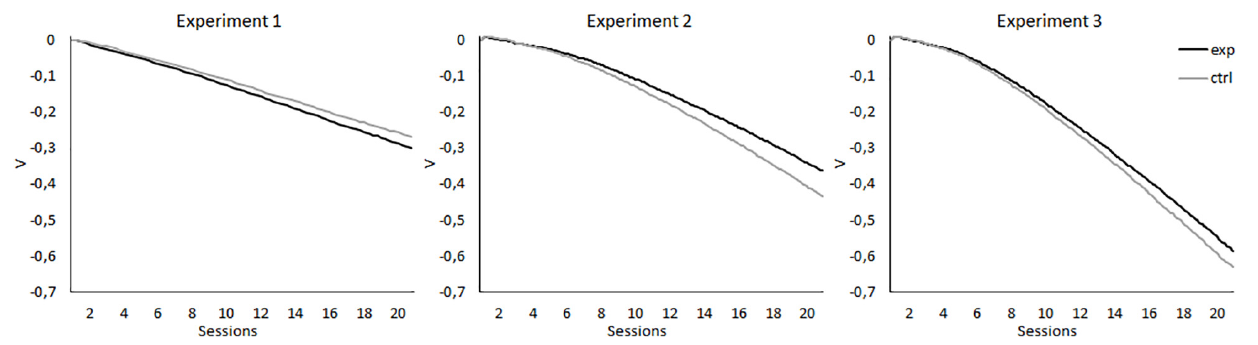
FIGURE 7 | Simulations of associative properties acquired by X according to Wagner’s Sometimes Opponent Processes (SOP) model, performed using the SOP model simulator (Byers et al., 2017), for the 20 sessions of the experimental designs reported. The left panel displays the simulation for Experiment 1, in which the experimental group (black line) was trained with 14 A+, two AX – , 12 F – , and two X – trials per session, and the control group (gray line) was trained with 14 A+, two BX – , 12 F – , and two X – trials per session. The central panel displays the simulations for Experiment 2, in which the experimental group (black line) was trained with eight A+, eight AX – , six F – , six F+, and two X – trials per session, and the control group (gray line) was trained with eight A+, eight BX – , six F – , six F+, and two X – trials per session. The right panel displays the simulations for Experiment 3, in which the experimental group (black line) was trained with five A+, 11 AX – , three F – , nine F+, and two X – trials per session, and the control group (gray line) was trained with five A+, 11 BX – , three F – , nine F+, and two X – trials per